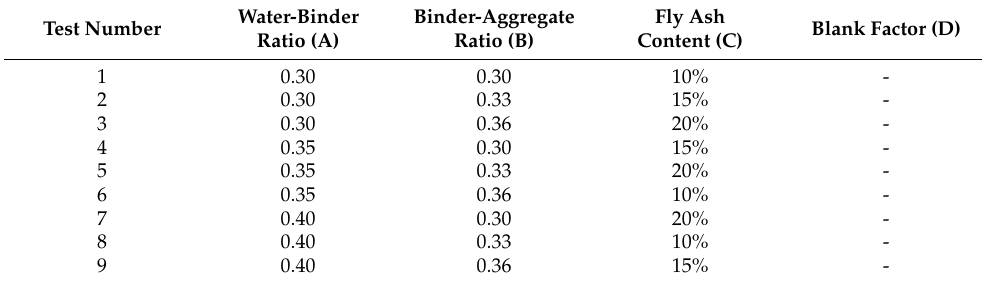
Table 3. The mix proportion design of orthogonal test L 9 (3 4 ).